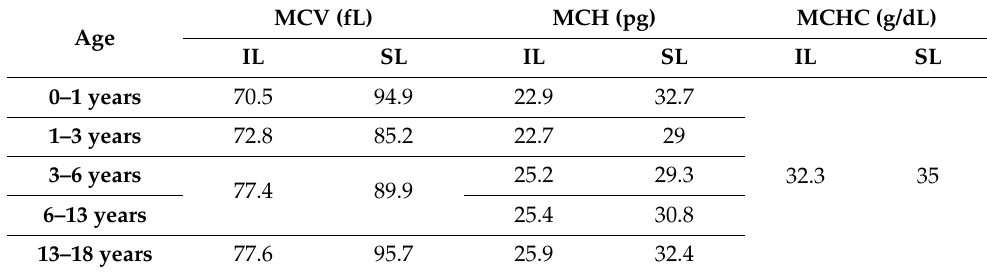
Table 3. Erythrocyte parameters values for age groups [11].